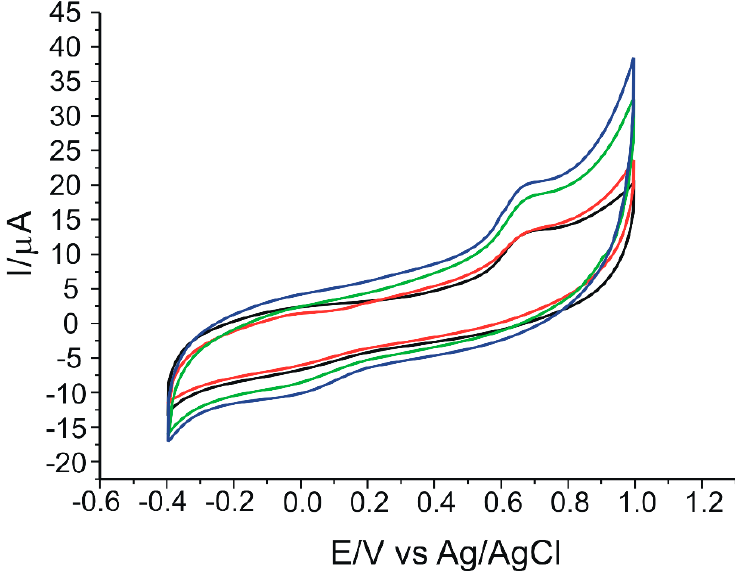
Figure 7. Cyclic voltammograms of sensors modified with: 10 μ L peptide solution, uncross-linked (black line); 10 μ L peptide solution, cross-linked (red line); 20 μ L peptide solution, uncross-linked (green line); 20 µ L peptide solution, cross-linked (blue line). All sensors immersed in 0.1 M PBS, pH = 6.5. Scan rate: 0.05 V · s − 1